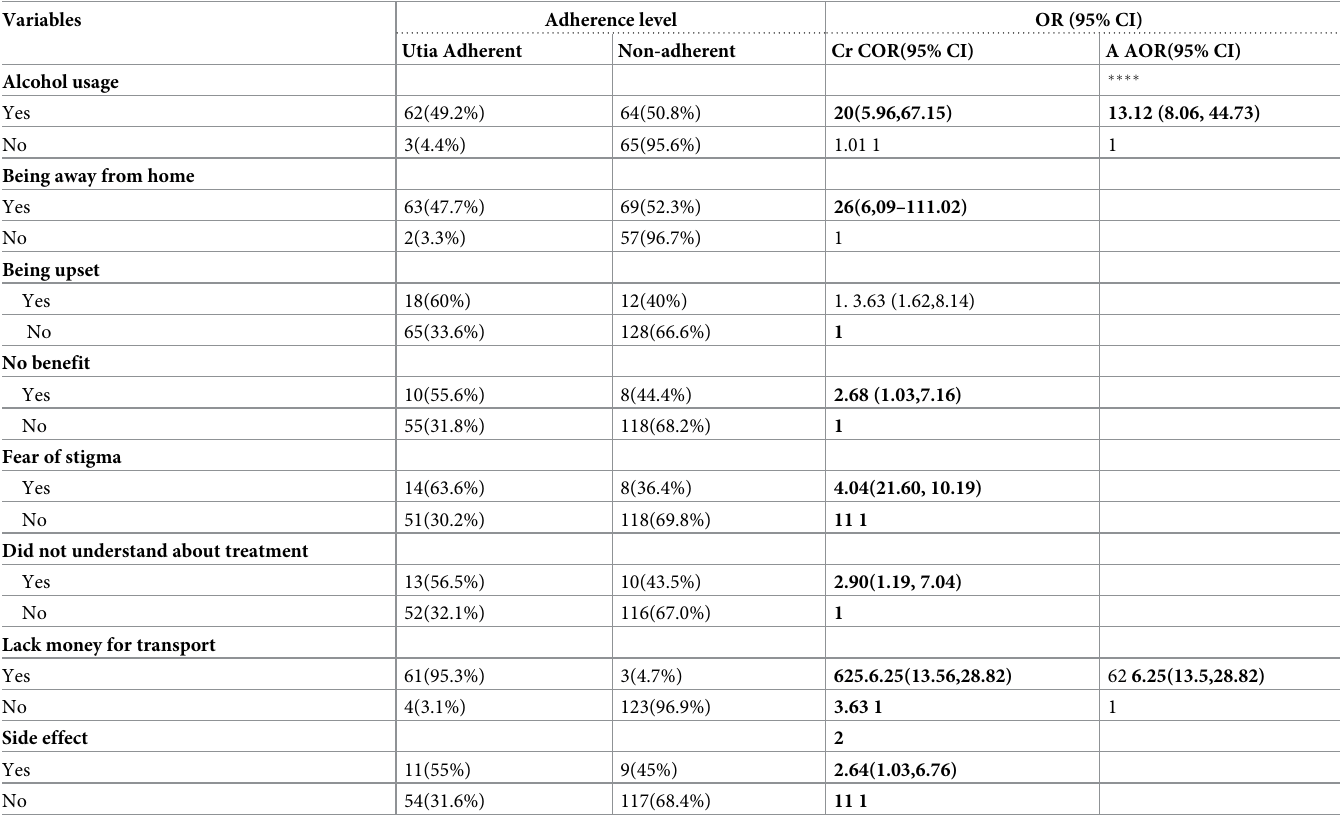
Table 4. Association between variable understudy and non-adherence diabetic treatment regimen among T2DM patients who attend the medical referral clinics for treatment and follow up at DURH,